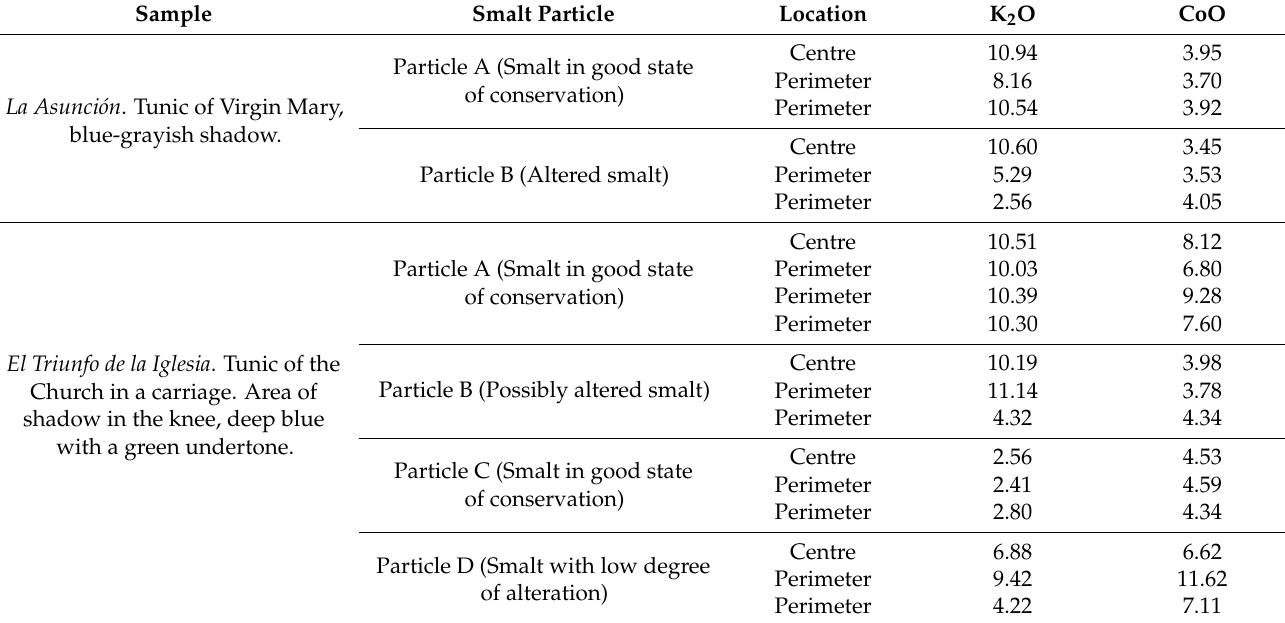
Cloud below Mary, blue-grayish shadow. Angel holding Mary, angel’s hand.